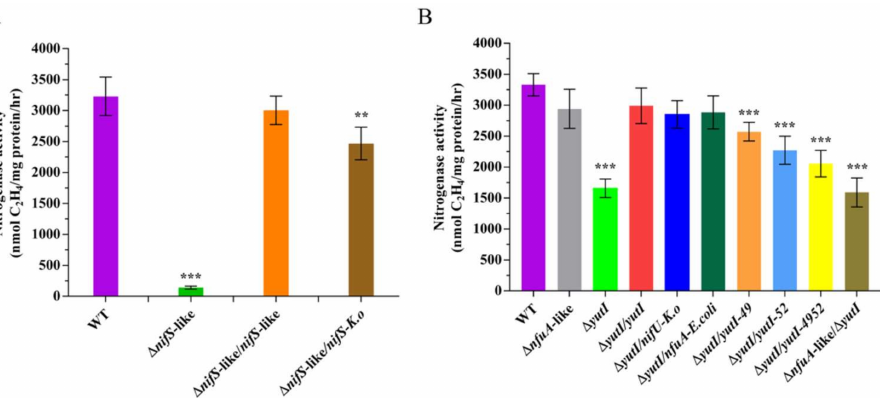
Figure 5. Effect of disruption of nifS- like and nifU- like genes on nitrogenase activity. ( A ) The nitroge- nase activities of wild-type (WT), ∆ nifS- like (deletion mutant), ∆ nifS- like /nifS- like (complementation strain), and ∆ nifS/nifS-K.o (complementation by K. oxytoca nifS ). ( B ) Nitrogenase activities of wild- type (WT), ∆ nfuA and ∆ yutI ( nfuA -like and yutI deletion mutant), ∆ yutI/yutI ( yutI complementation strain), ∆ yutI/nifU (complementation by K. oxytoca nifU ), ∆ yutI/nfuA-E. coli (complementation by E. coli nfuA ), ∆ yutI/yutI-49, ∆ yutI/yutI-52 , ∆ yutI/yutI-4952 (cysteine variants of the YutI complementation strain), and ∆ nfuA -like/ ∆ yutI ( nfuA -like and yutI double mutant). The nitrogenase activities were assayed by the C 2 H 2 reduction method and expressed in nmol C 2 H 4 /mg protein/hr. The nitrogenase activity of the WT strain was used as a control. Results are representative of at least three independent experiments. Error bars indicate the SD. ** p < 0.01; *** p <